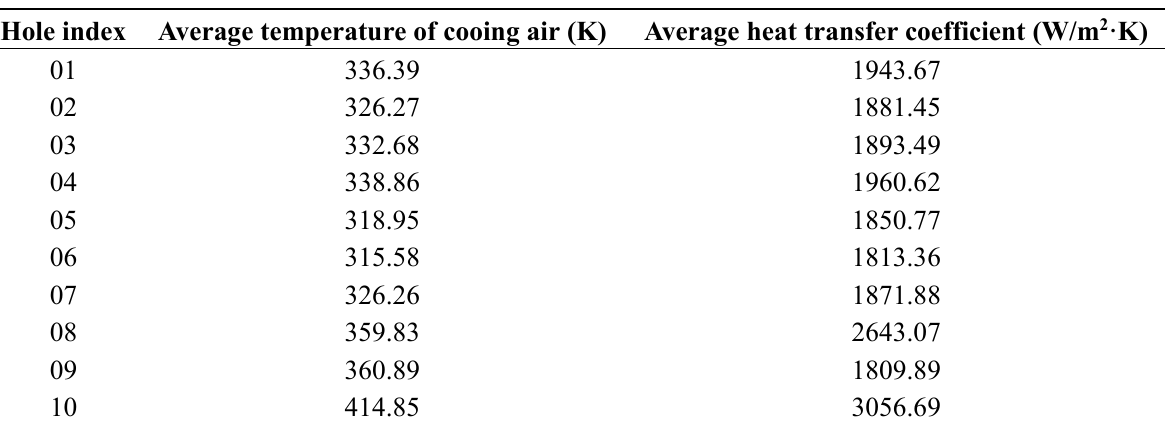
Table 2. Test condition parameters of inner holes boundaries for the case of the turbine vane Mark II.